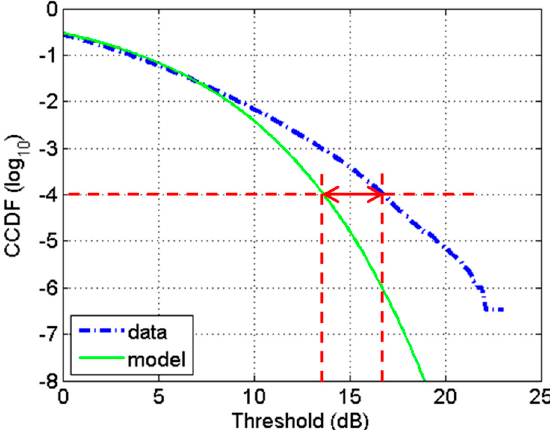
Figure 3. Measurement of the threshold error at 10 − 4 between the actual CCDF (blue thick dotted line) and the model CCDF (green line).